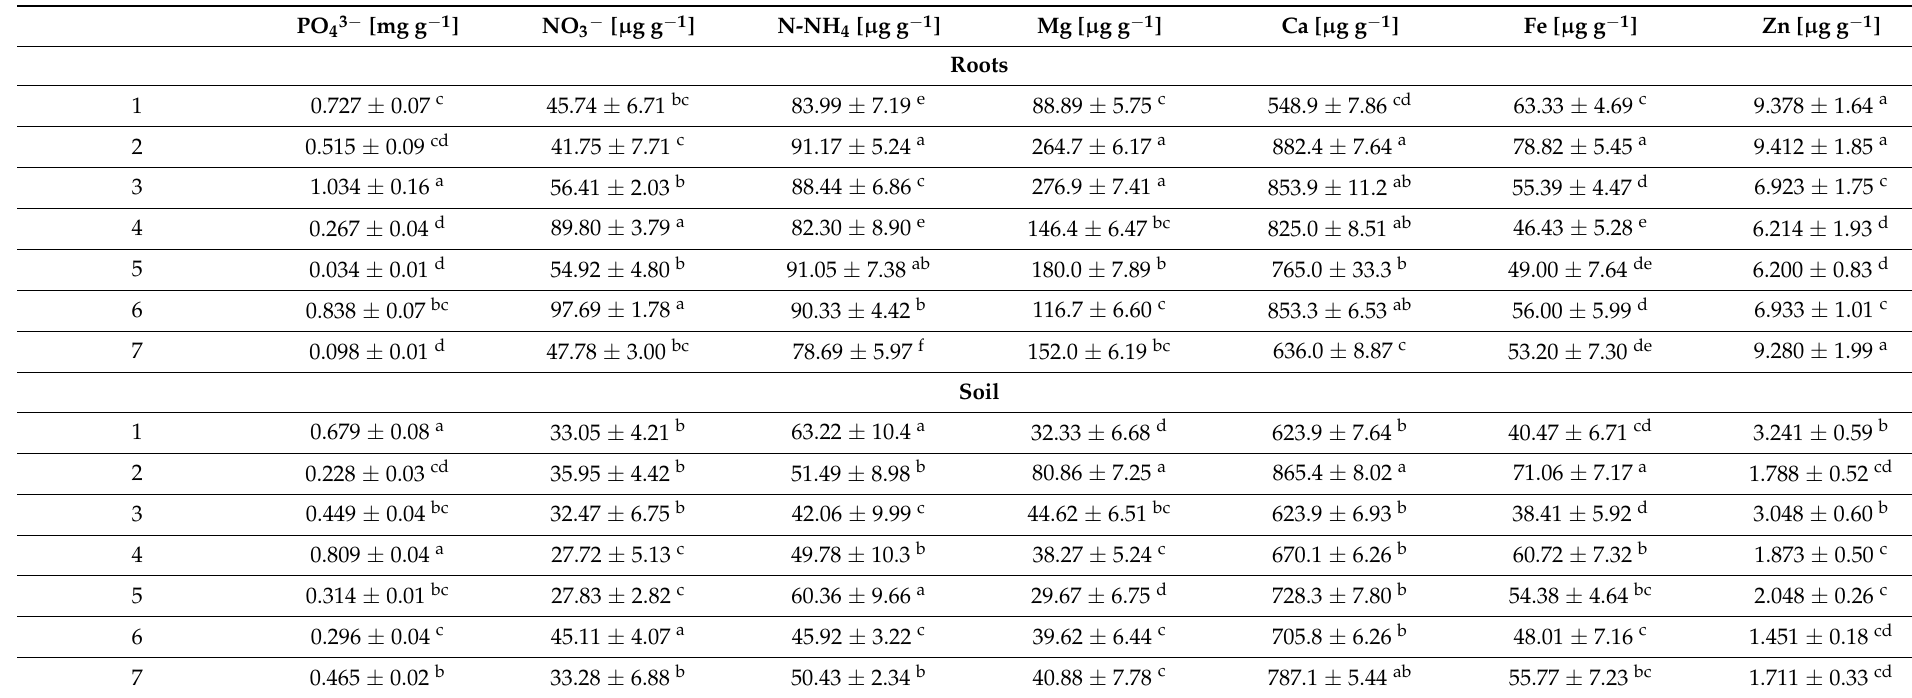
Table 3. Concentrations of macro and micronutrients in the dry weight of the soil and plant tissues. The numbers 1–7 correspond to the respective variants: 1—control, 2—Macro